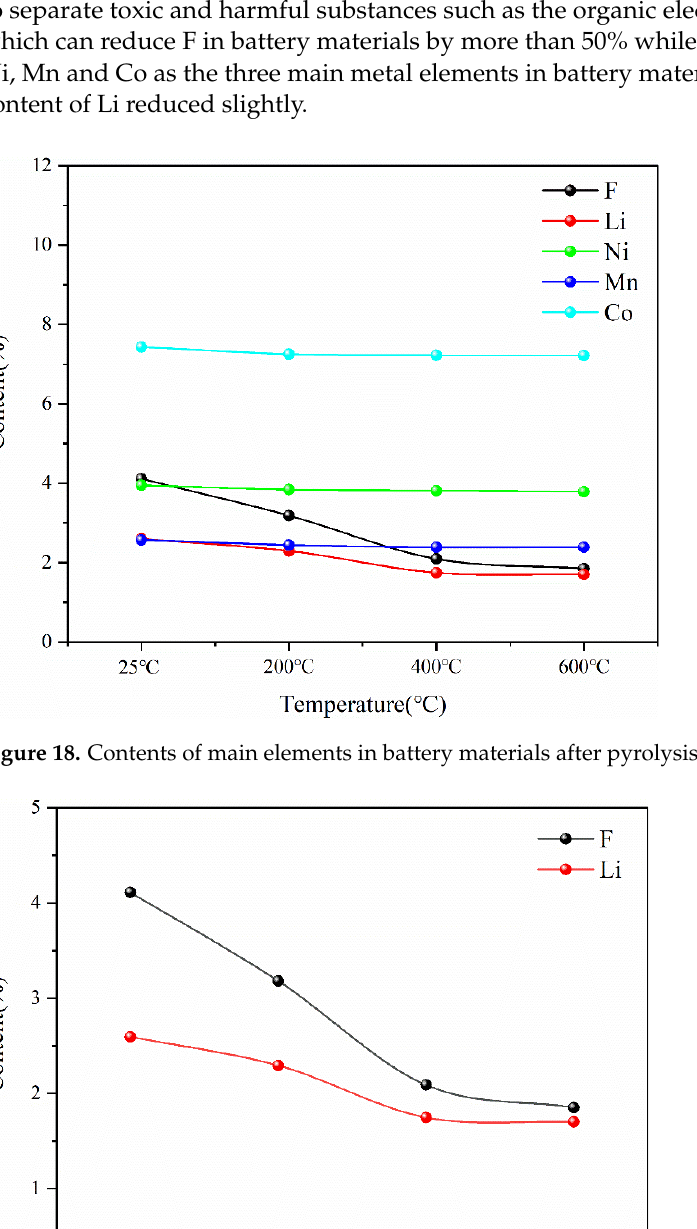
Table 4. Gas composition during pyrolysis detected by GC-MS. Number